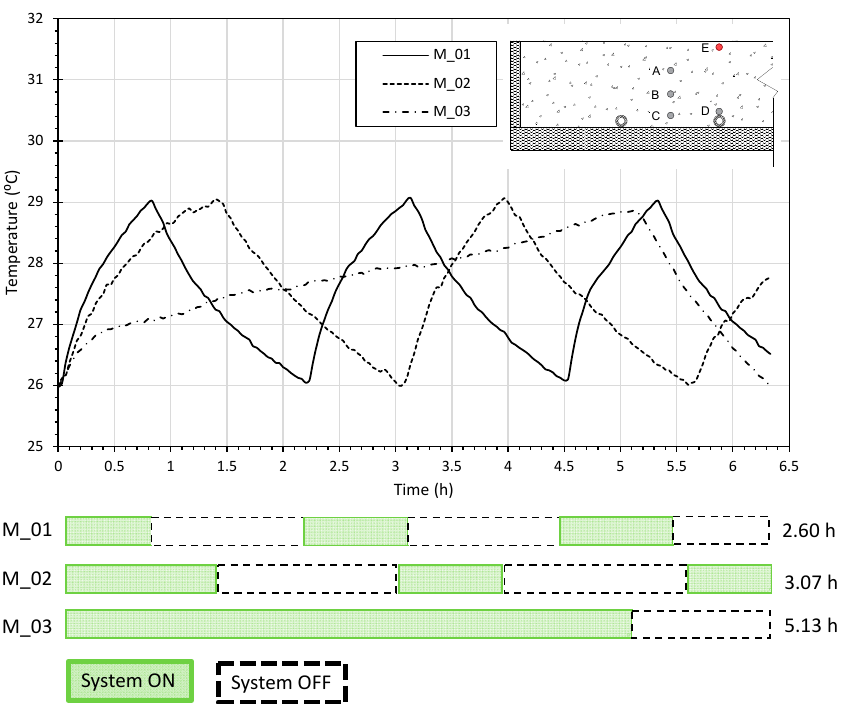
Figure 5. Temperature profile and representative time of system turned on and off for heating (system charge) and discharge (passive behaviour).